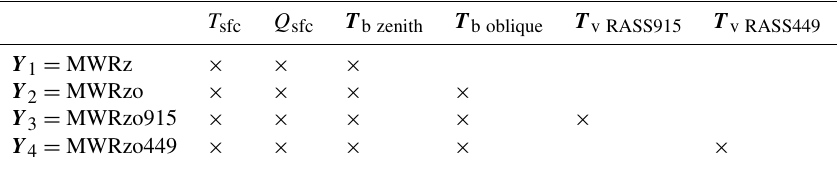
Table 1. Four PR configurations corresponding to the four observational Y i vectors in Eq. (1). T sfc Q